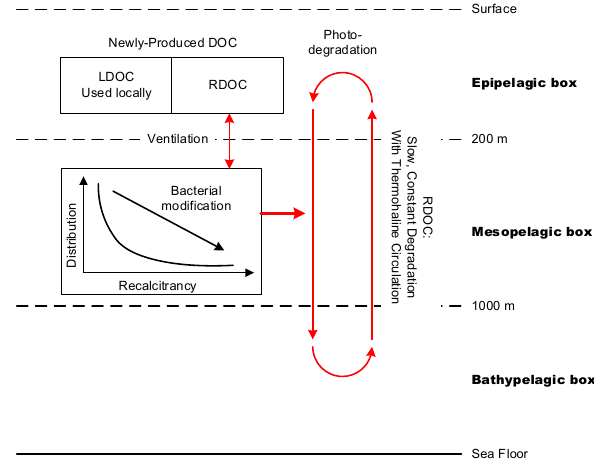
Figure 7. A conceptual framework for ecosystem